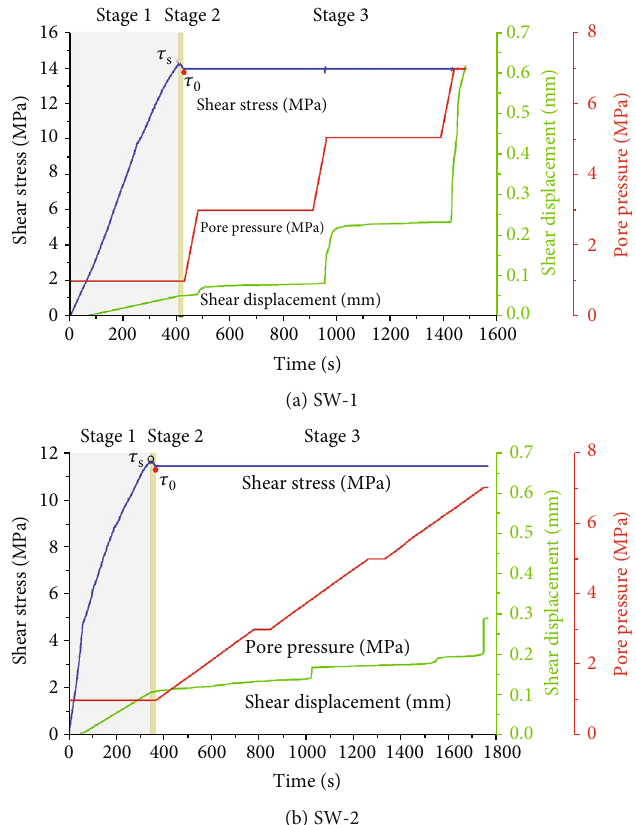
Figure 2: Stress-displacement evolution in stepping injection-induced shear tests. Please notice the di ff erence in the coordinate